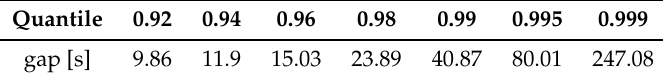
Table 2. CSMA quantiles (mean of 256_5T0 configurations).